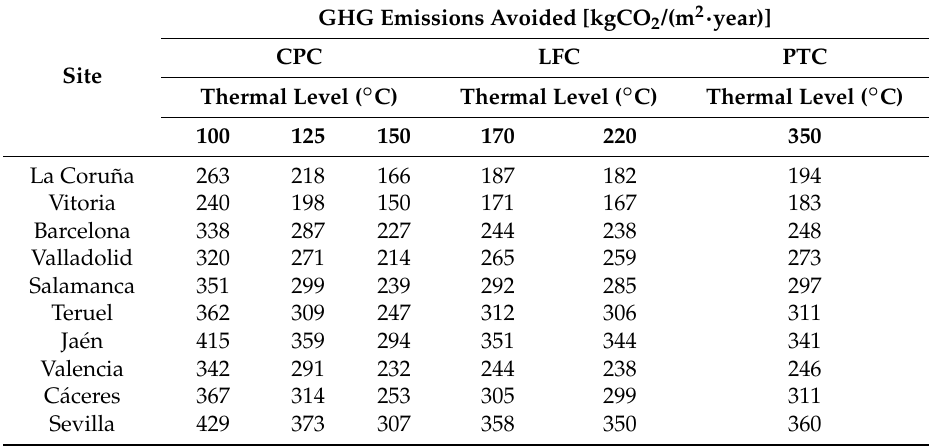
Table 27. GHG emissions annually avoided by the use of solar technologies instead of